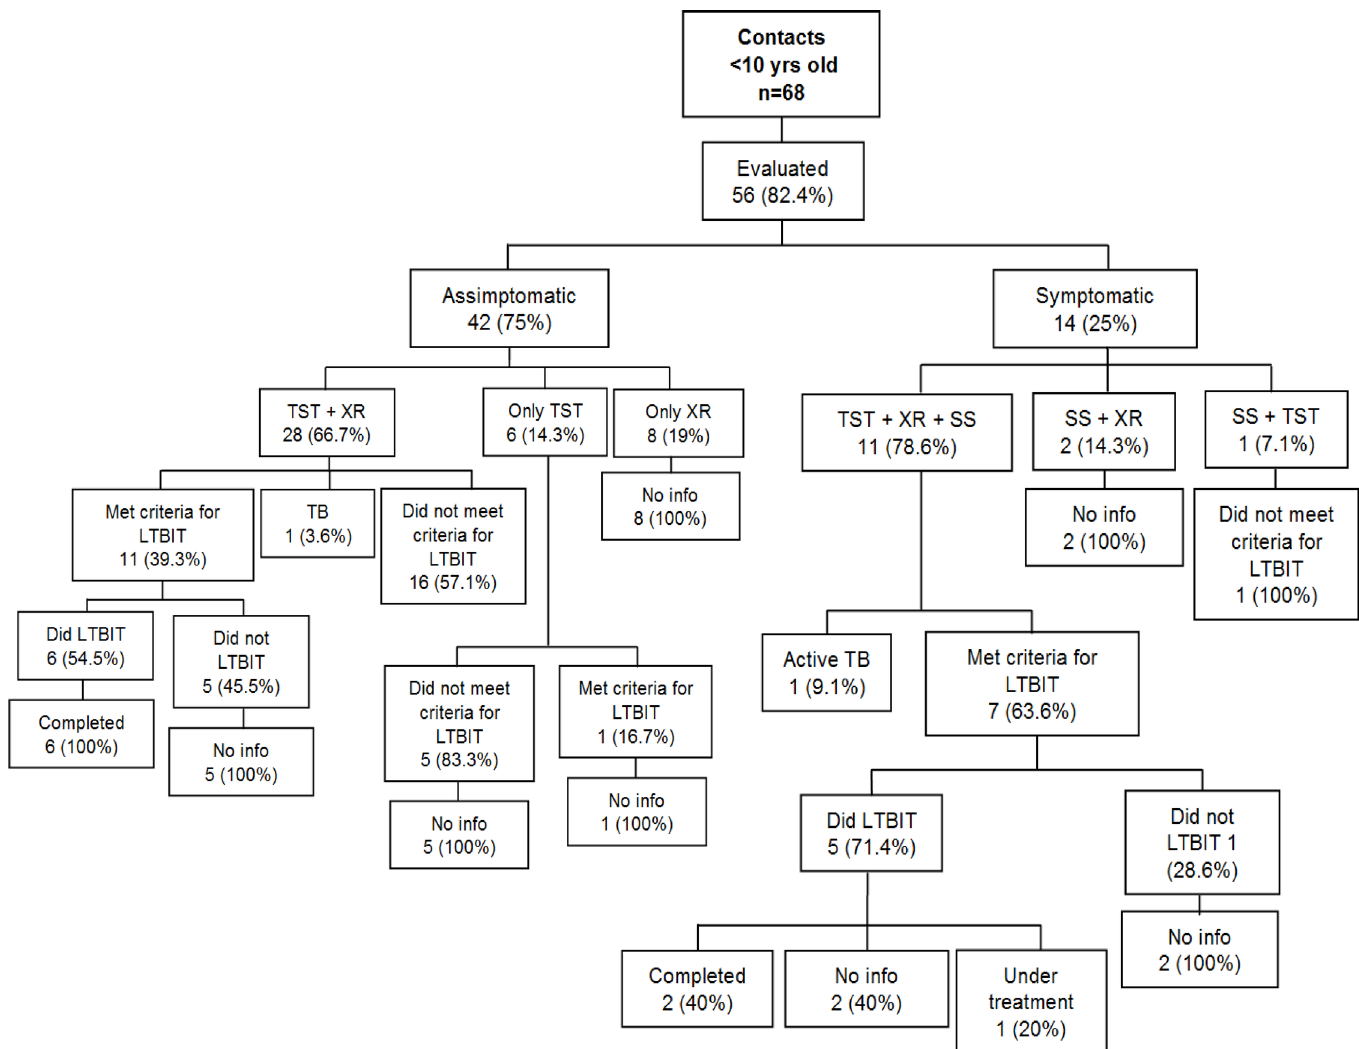
Fig 2. Description of the outcomes of the child contact investigation, Sao Jose do Rio Preto- SP, Brazil, 2012 – 2013.